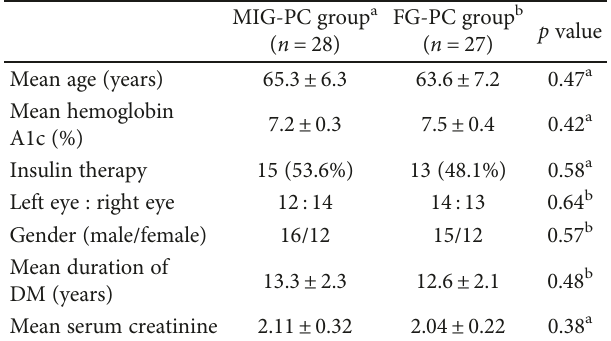
Figure 2: Steps for marking the location of microaneurysms (MAs) in the merged image-guided photocoagulation (MIG-PC) method. (a) Ocular fundus photograph shows focal diabetic macular edema accompanied by a hard exudate ring. (b) OCT map is overlaid on the fundus photograph. (c) Image of fl uorescein angiography (FA) is merged with the fundus photograph and OCT map. (d) High- magni fi cation image corresponding to the rectangular area is indicated with white-dashed line in Figures 2(a) and 2(c). (e) MAs are marked on the ocular fundus as yellow circles. Table 1: Baseline characteristics at the time of